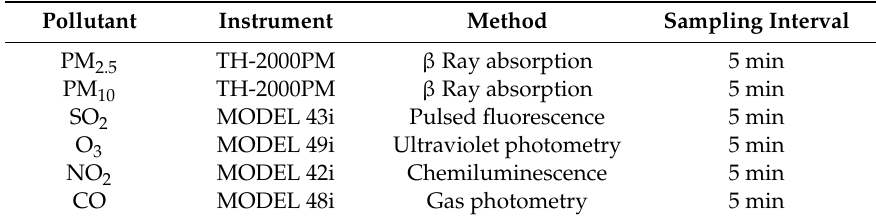
Table 2. List of experimental instruments for major